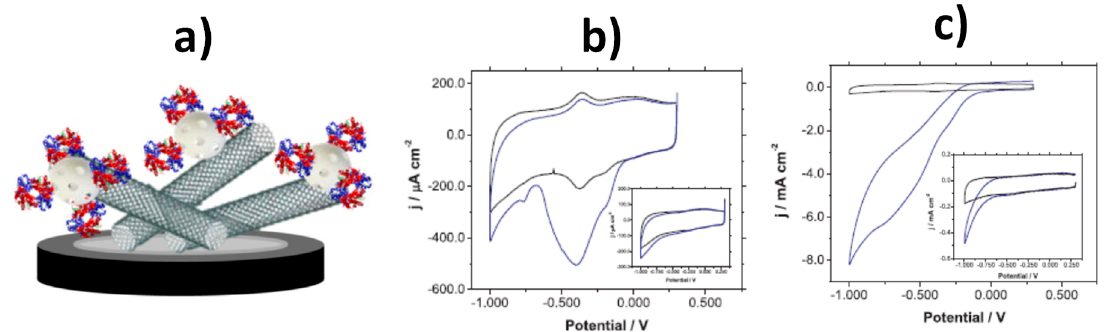
voltammograms obtained in a N 2 -saturated 0.050 M phosphate buffer solution pH 7.00 in the absence (black) and presence (blue) of 1.5 × 10 − 2 M NaNO 2 ( b ) and 0.100 M TCA ( c ) at GCE/MWCNTs-MCM41- Hb. Inset: corresponding CVs obtained at GCE/MWCNTs. Reprinted and adapted from [165] with permission.